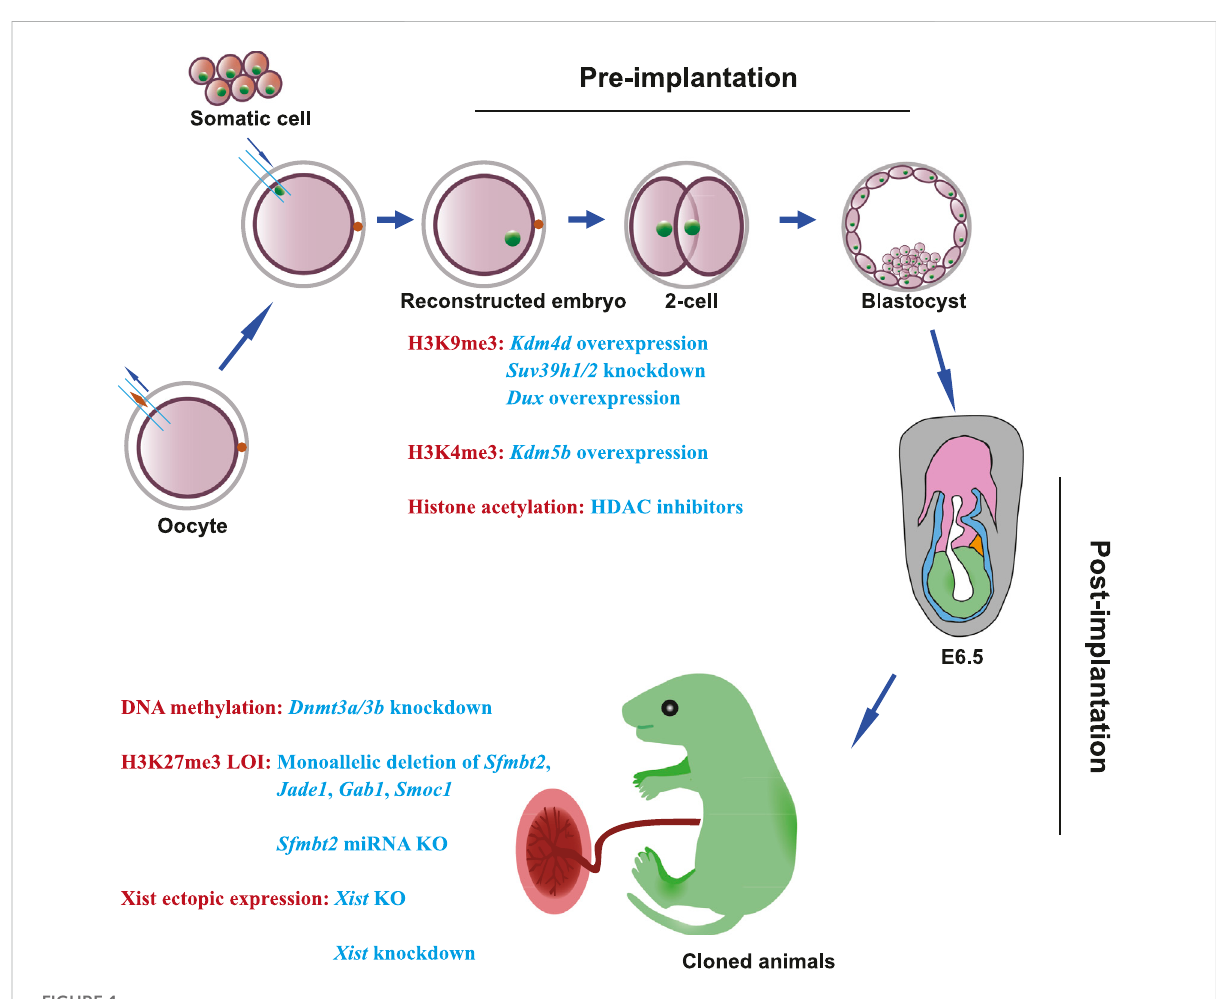
FIGURE 1 Epigenetic barriers and strategies to overcome developmental defects in SCNT embryos. During the development of SCNT embryos, epigeneticbarriers canbeclassi fi edintotwocategories:oneispre-implantationdefects; theotherispost-implantationdefects.Inpre-implantation of SCNT embryos, H3K9me3 deposition can be overcome by Kdm4 overexpression, Suv39h1/2 knockdown, and Dux transient overexpression. H3K4me3 deposition can be solved by Kdm5b injection. HDAC inhibitors can alleviate histone acetylation. In post-implantation of SCNT embryos, Dnmt3a/3b knockdown can improve post-implantation development. To overcome the loss of imprinting in H3K27me3 imprinted genes, generation of monoallelic deletions of Sfmbt2, Jade1 , Gab1 , and Smoc1 , or deletion of Sfmbt2 miRNA can fi x aberrant placentas and improve